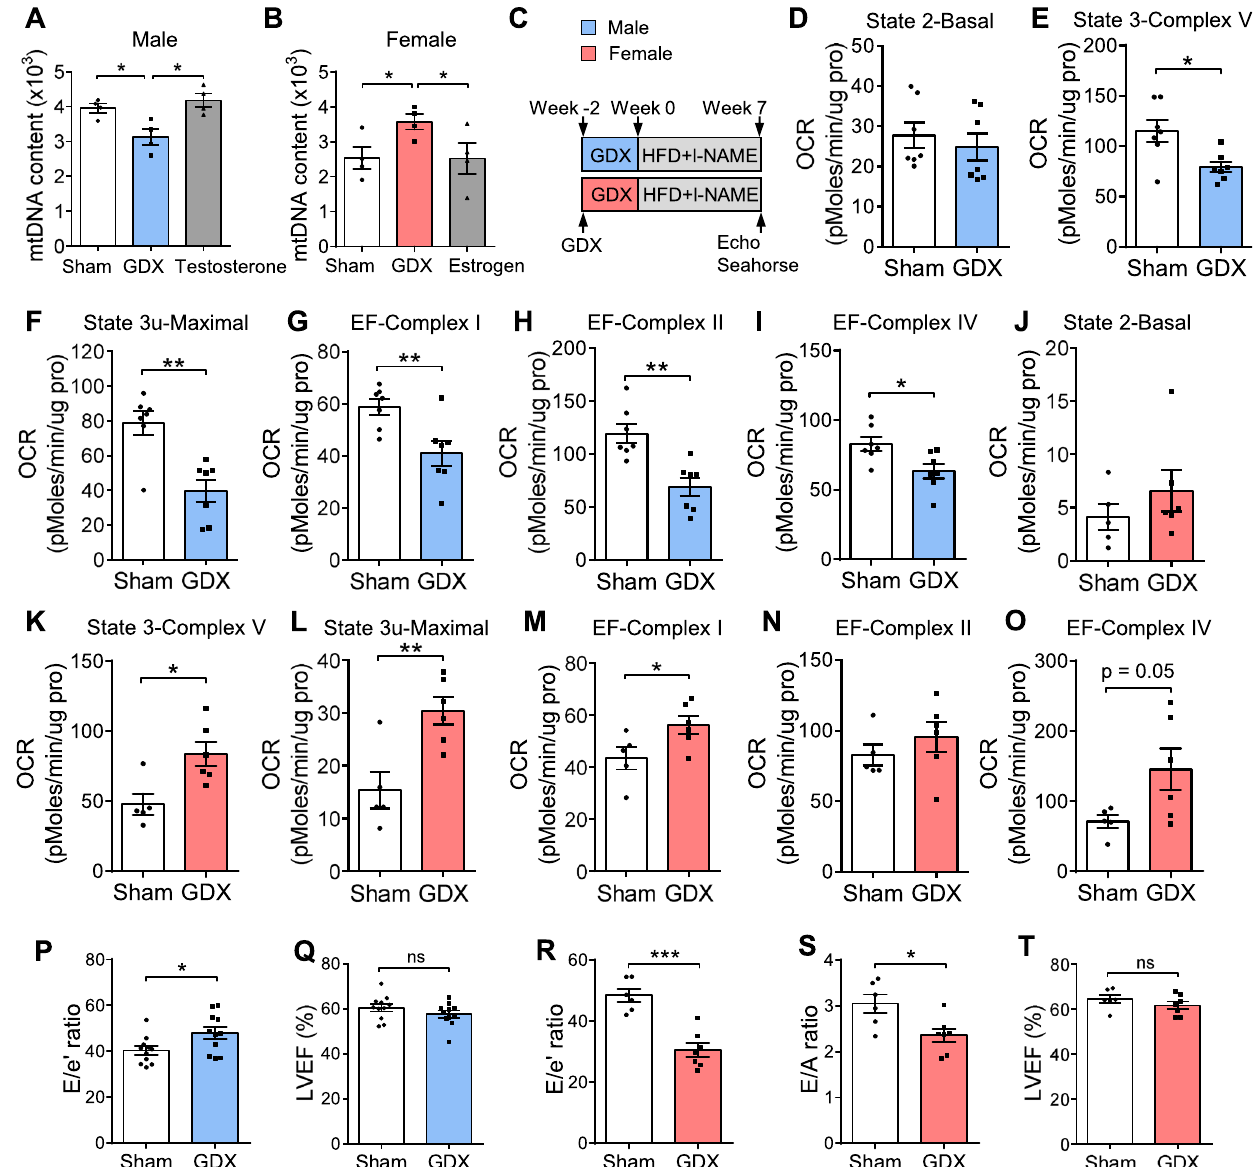
Fig. 3 Mitochondrial and diastolic function in gonadectomized mice. A, B Heart mtDNA copy number in C57BL/6 J male ( A ) and female ( B ) mice subjected to sham, gonadectomy or hormone replacement after gonadectomy under chow diet. mtDNAs were normalized to nuclear DNA. N = 4. A p = 0.019 (Sham/GDX) and 0.013 (GDX/Testosterone). B p = 0.036 (Sham/GDX), and 0.04 (GDX/Estrogen). C Experimental timeline for the gonadectomy and induction of HFpEF in C57BL/6 J male and female mice. D – I Oxygen consumption rates (OCR) of isolated mitochondria from C57BL/6J male hearts were measured by Seahorse assay. The coupling assay measures basal respiration in presence of palmitoyl-carnitine, state 3 (ADP) and state 3 u (FCCP). The electron fl ow measures complex I (palmitoyl-carnitine), complex II (succinate), and complex IV (TMPD) respiration. N = 7. E p = 0.012. F p = 0.001. G p = 0.008. H p = 0.001. I p = 0.017. J – O Same Seahorse assays were performed in C57BL/6 J female mice after gonadectomy and 7 weeks of HFD + l-NAME feeding. Sham, n = 5; GDX, n = 6. K p = 0.013. L p = 0.006. M p = 0.049. P , Q E/e ’ ratio ( P ) and LVEF ( Q ) of C57BL/6 J male mice after gonadectomy and 7 weeks of HFD + l-NAME diet. N = 11. P p = 0.027. R – T E/e ’ ratio ( R ), E/A ratio ( S ), and LVEF ( T ) of C57BL/6 J female mice after gonadectomy and 7 weeks of HFD + l-NAME diet. Sham, n = 6; GDX, n = 7. R p = 0.0001. S p = 0.016. Each point represents a mouse. All data are presented as the mean ± SEM. ns not signi fi cant, * P < 0.05, ** P < 0.01, and *** P < 0.001, by one-way ANOVA ( A , B ) or by two-sided Student ’ s t -test ( D – T ). Source data are provided as a Source Data fi